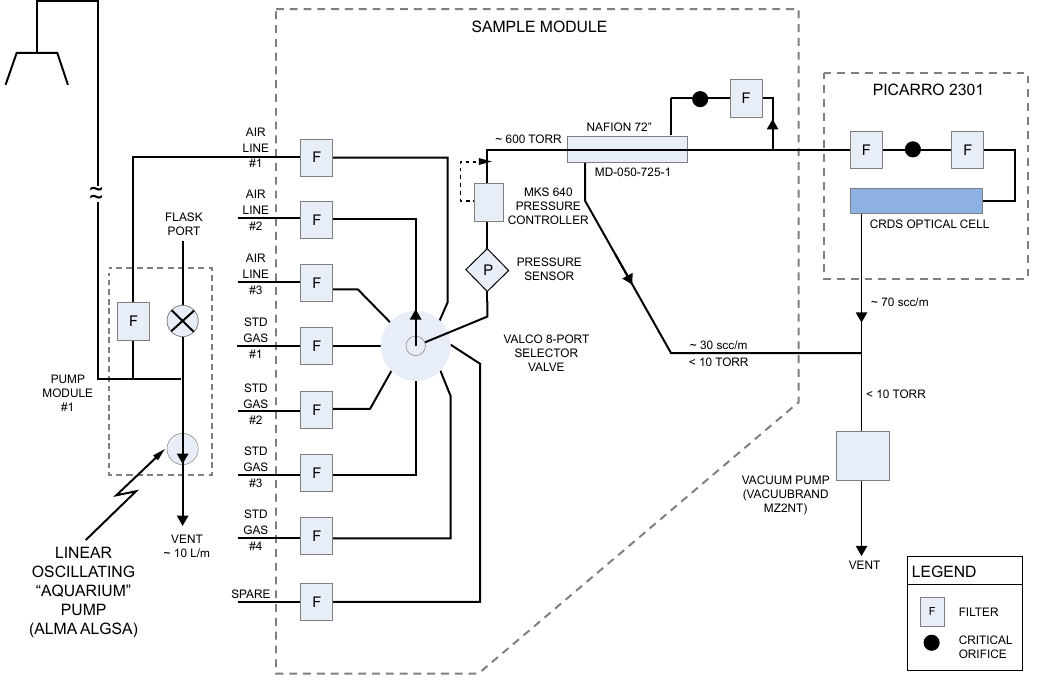
Fig. 1. The gas-handling configuration for the Earth Networks greenhouse gas monitoring stations. The “Sample Module” houses the Nafion dryer system. All sample air and reference gases pass through the Nafion